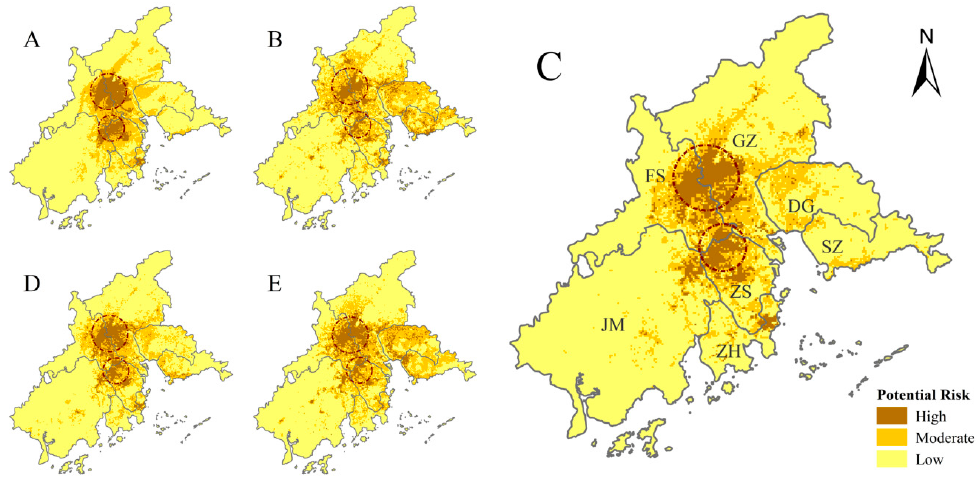
Figure 5. Areas of Dengue Fever outbreak risk, as calculated by the different models (where the letters A – E relate to the aggregated results from each model). Model definitions are found in Table 3. Model C is the model that we believe best fits the data. Dotted circles indicate areas at highest risk, as chosen by all models.